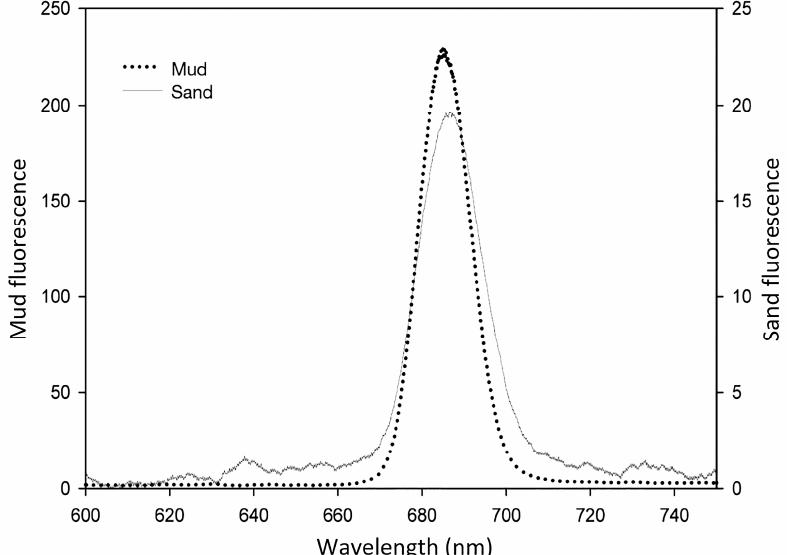
Figure 2. Typical LIF spectra of microphytobenthos in mud and sand intertidal sediments (reprinted from Vieira [61] with permission).